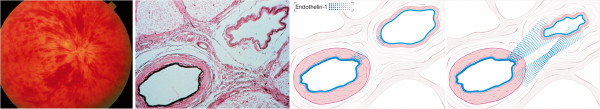
Pathogenesis of retinal vein occlusion. At the lamina cribrosa, the central retinal artery and central retinal vein are topographically very close and share a common adventitia (middle). This enables a molecular crosstalk between the two vessels (right). ET-1 (blue), for example, can diffuse from the ailing artery as well as from the adjacent hypoxic tissue to the very sensitive vein, leading to venous constriction. (Modified from [84], with kind permission from Springer Science + Business Media B.V.).